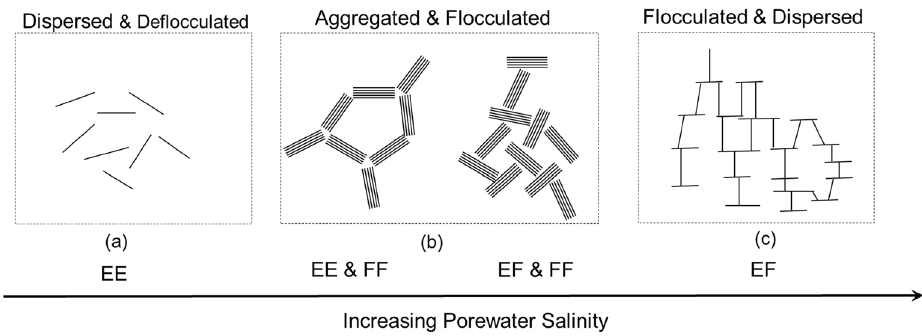
Figure 4. Soil structures and porewater salinity (modified after Mitchell and Soga 51